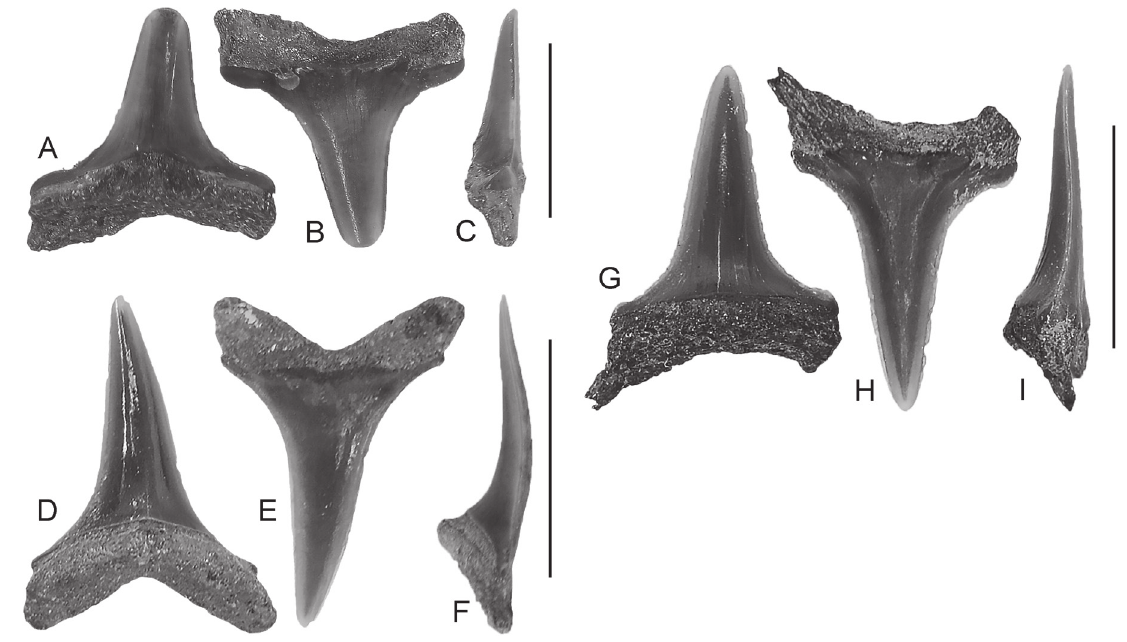
Fig. 10. Anomotodon sp., teeth. A – C . MSC 35766.1, lower Tallahatta Formation. A . Lingual view. B . Labial view. C . Distal view. D – F . MSC 37660, Tallahatta/Lisbon formation contact zone, courtesy of Bruce Relihan. D . Lingual view. E . Labial view. F . Mesial view. G – I . MSC 37503, Gosport Sand. G . Lingual view. H . Labial view. I . Distal view. Scale bars =